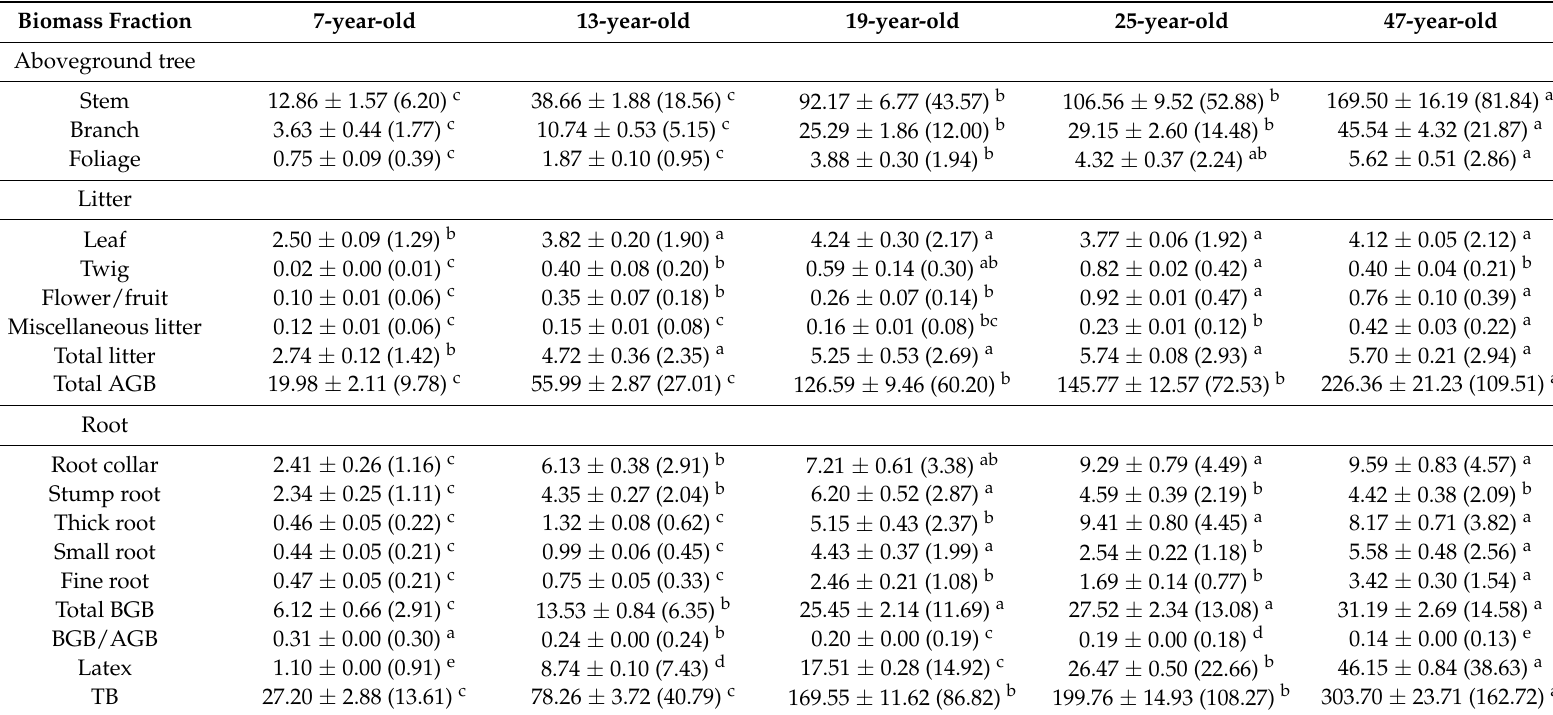
Table 2. Above- and belowground biomass and latex yield (t ha − 1 ) and carbon stock (in brackets Mg C ha − 1 ) in different compartments of the 7-, 13-, 19-, 25- and 47-year-old rubber plantations at Xishuangbanna, Yunnan Province,